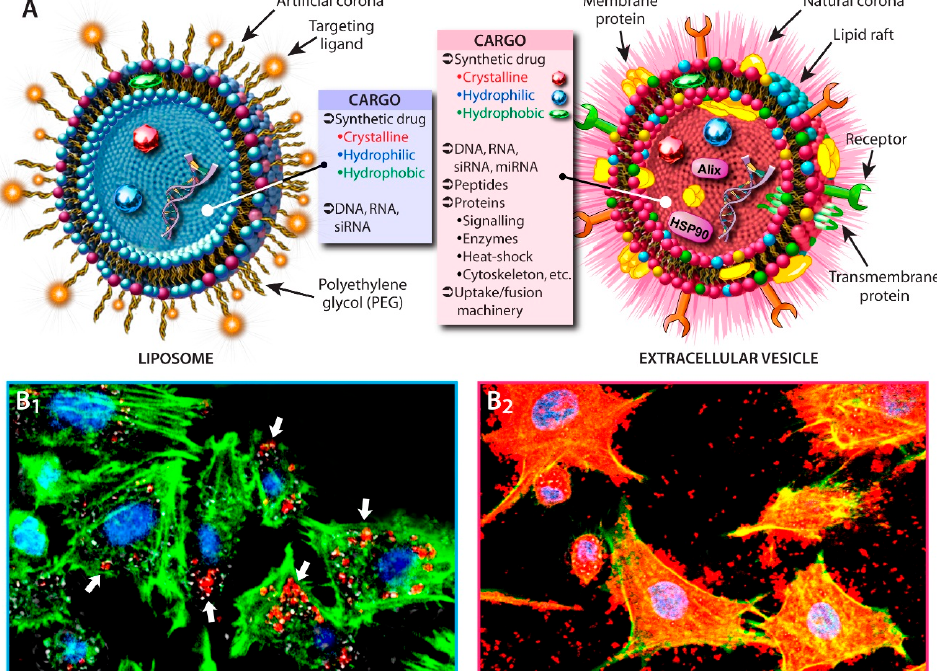
Figure 2. Comparison of liposomes and extracellular vesicles (EVs) as drug-delivery-systems (DDS). ( A ) Schematic depiction of lipid-based vesicular carriers (not to scale). Note that in comparison to liposomes, EV membranes not only consist of a diverse number of lipid classes, but also contain trans-membrane and membrane-associated proteins, receptors, adhesion molecules, as well as a natural corona. Such features must be engineered into liposomes to obtain a stable and suitable DDS; ( B ) Accumulation of exosomes is profoundly higher (B 2 ) than accumulation of artificial nano-carriers such as liposomes (B 1 ; white arrows) in PC12 neuronal cells after 24 h incubation [12]. Red (Dil, C 59 H 97 ClN 2 O 4 ): exosomes or nano-carriers; Green (rabbit anti-PGP9.5): actin microfilaments; Blue (DAPI): nuclei.